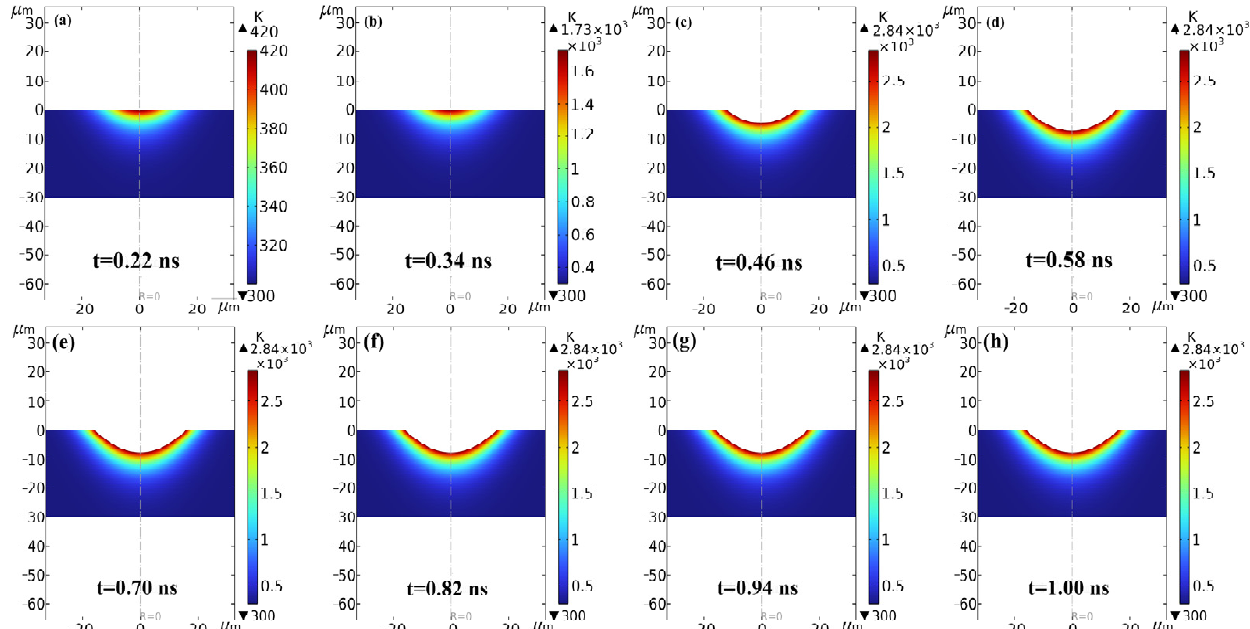
Figure 11. Simulation results of etched morphology at different moments.